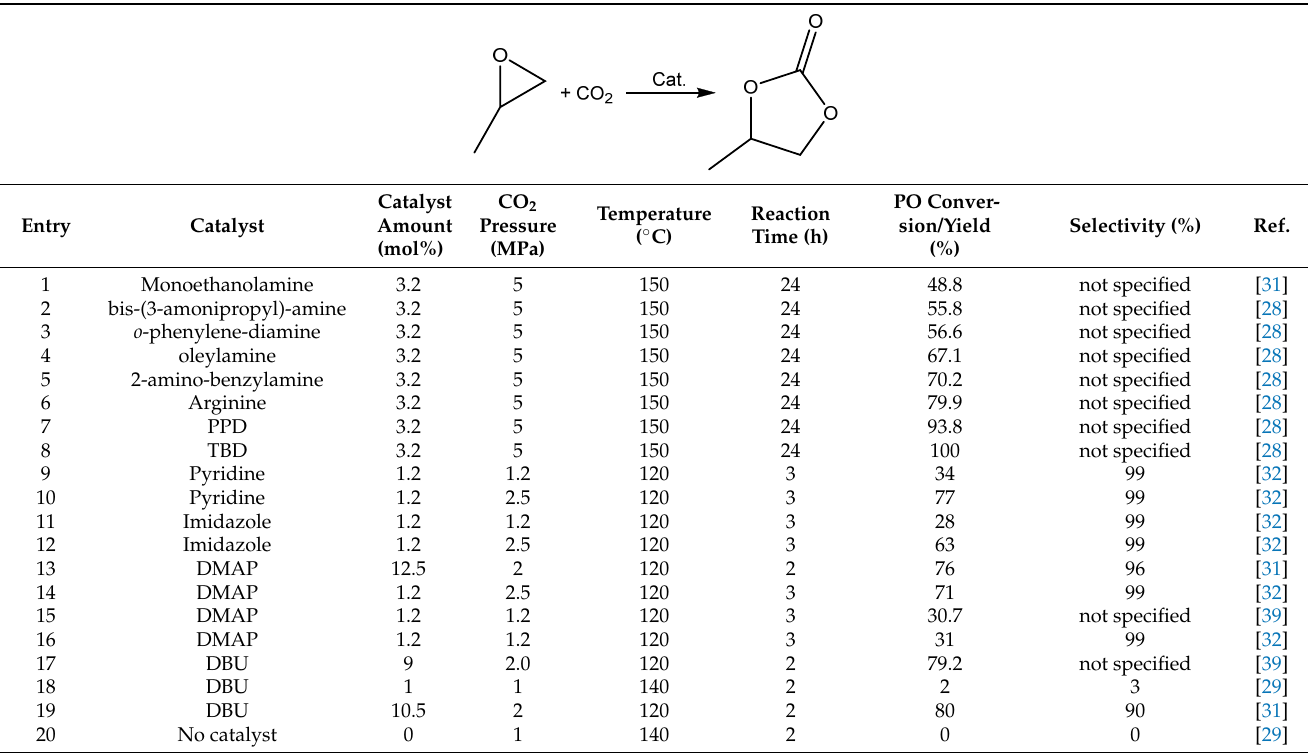
Table 1. Effect of amine structure on the cycloaddition of CO 2 to propylene oxide (PO) producing propylene carbonate (PC).